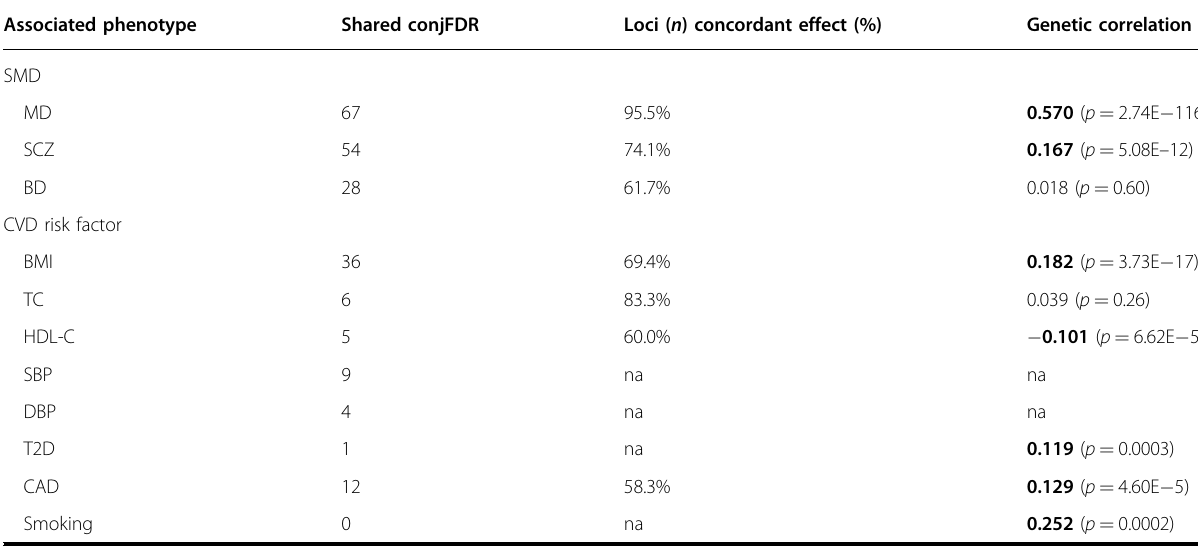
Table 1 Shared loci between loneliness and SMDs and CVD risk